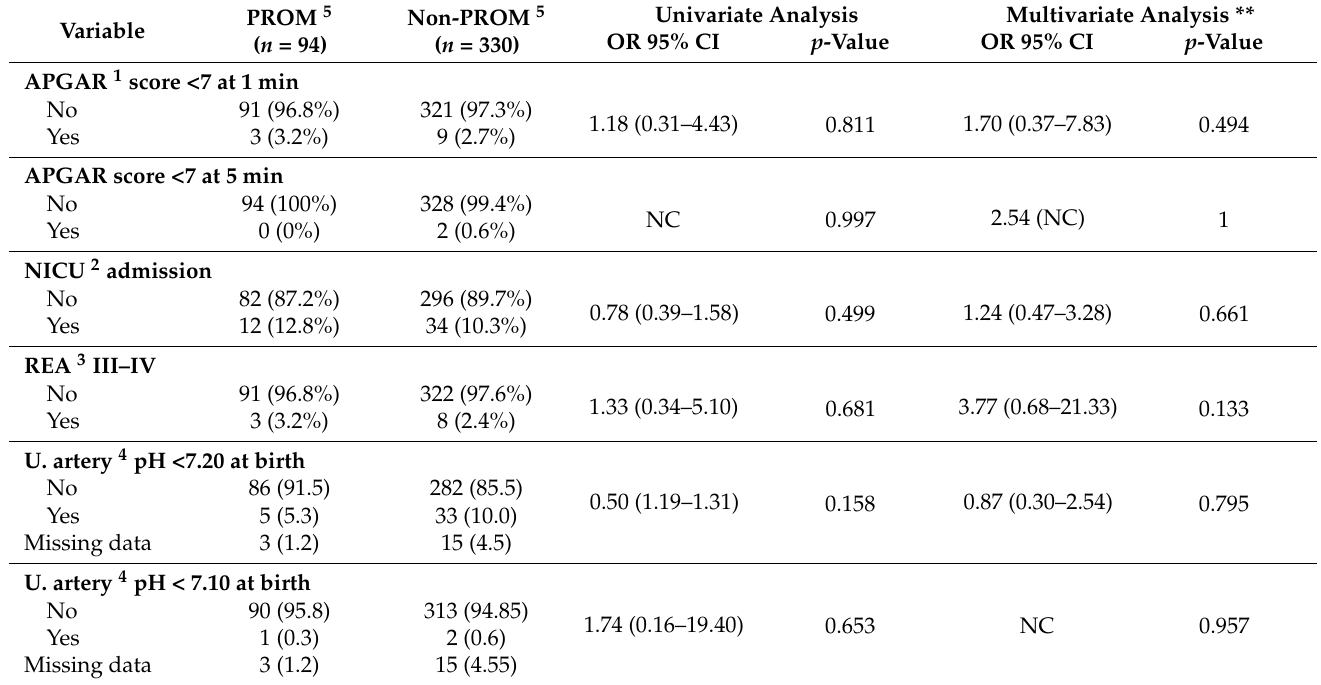
Table 3. Neonatal outcomes in the study population according to